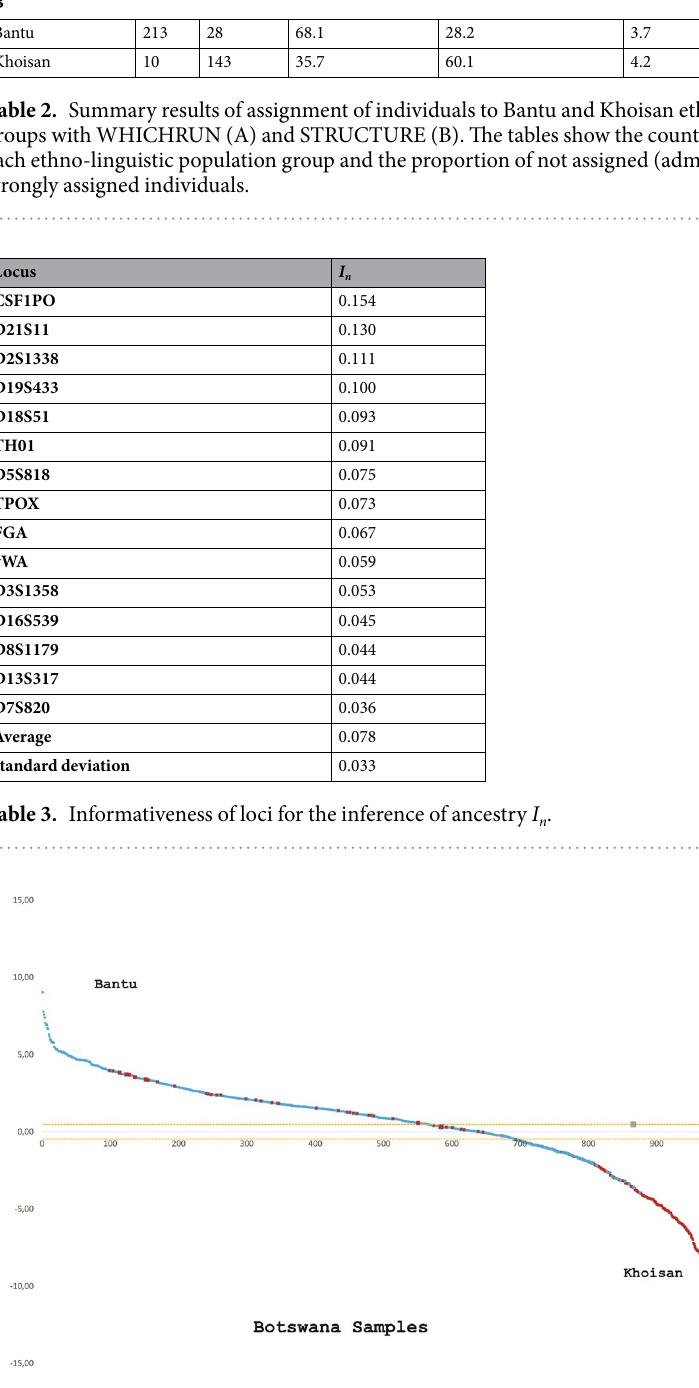
Figure 5. Log likelihood ratios of assignment for all 990 Botswana individuals to Bantu and Khoisan ethno- linguistic groups. The cut off range for Bantu was ≥ 0.477 (log103) and for Khoisan it was <− 0.477. The self- declared Bantu individuals are indicated in blue and the Khoisan in maroon. The samples that fall within the purple dashes represent admixed individuals.